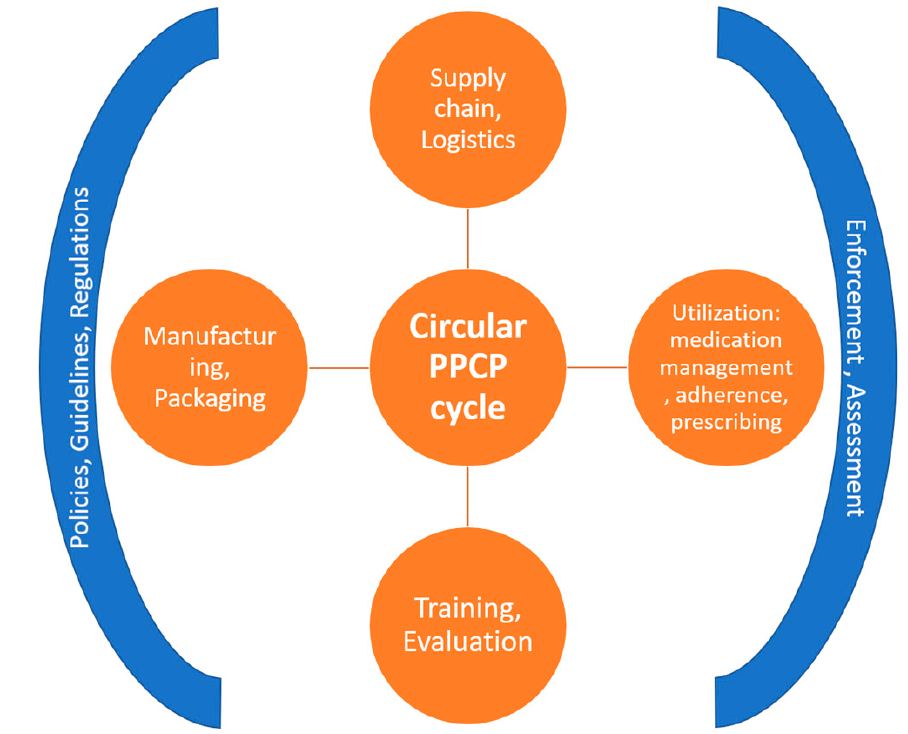
Figure 1. Circular economy applied to PPCPs.